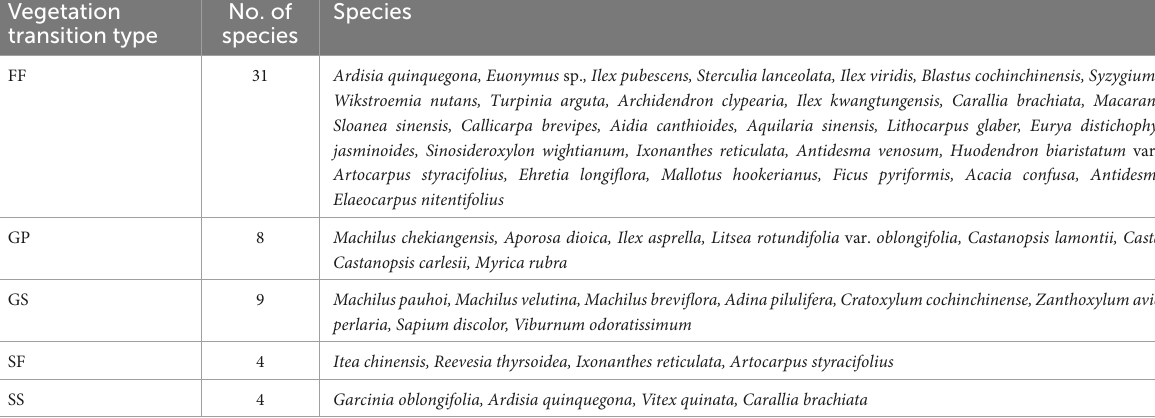
TABLE 3 Species positively associated with each vegetation transition type (VTT). Vegetation transition